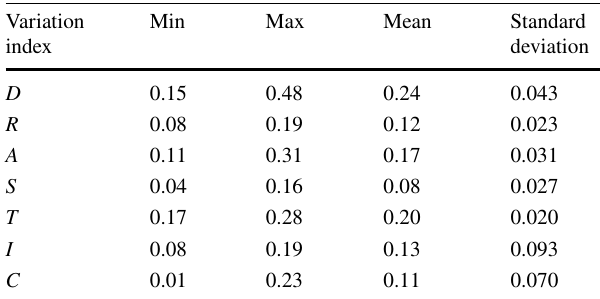
Table 10 Variation index of the excluded DRASTIC model parameter